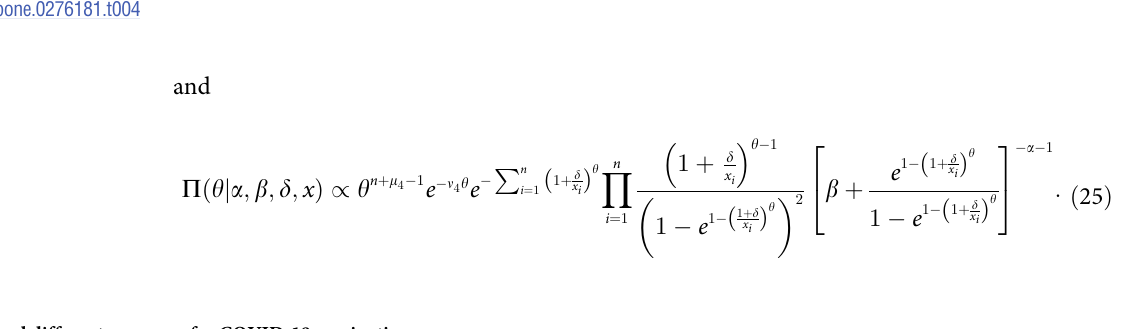
Table 5. MLE estimates, SE, and different measures for COVID-19